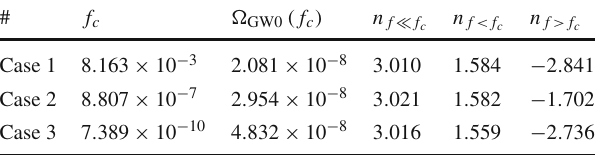
Table 5 The frequencies and heights of the peak of the spectrum of the current fractional energy density of the secondary GWs for Cases 1, 2, and